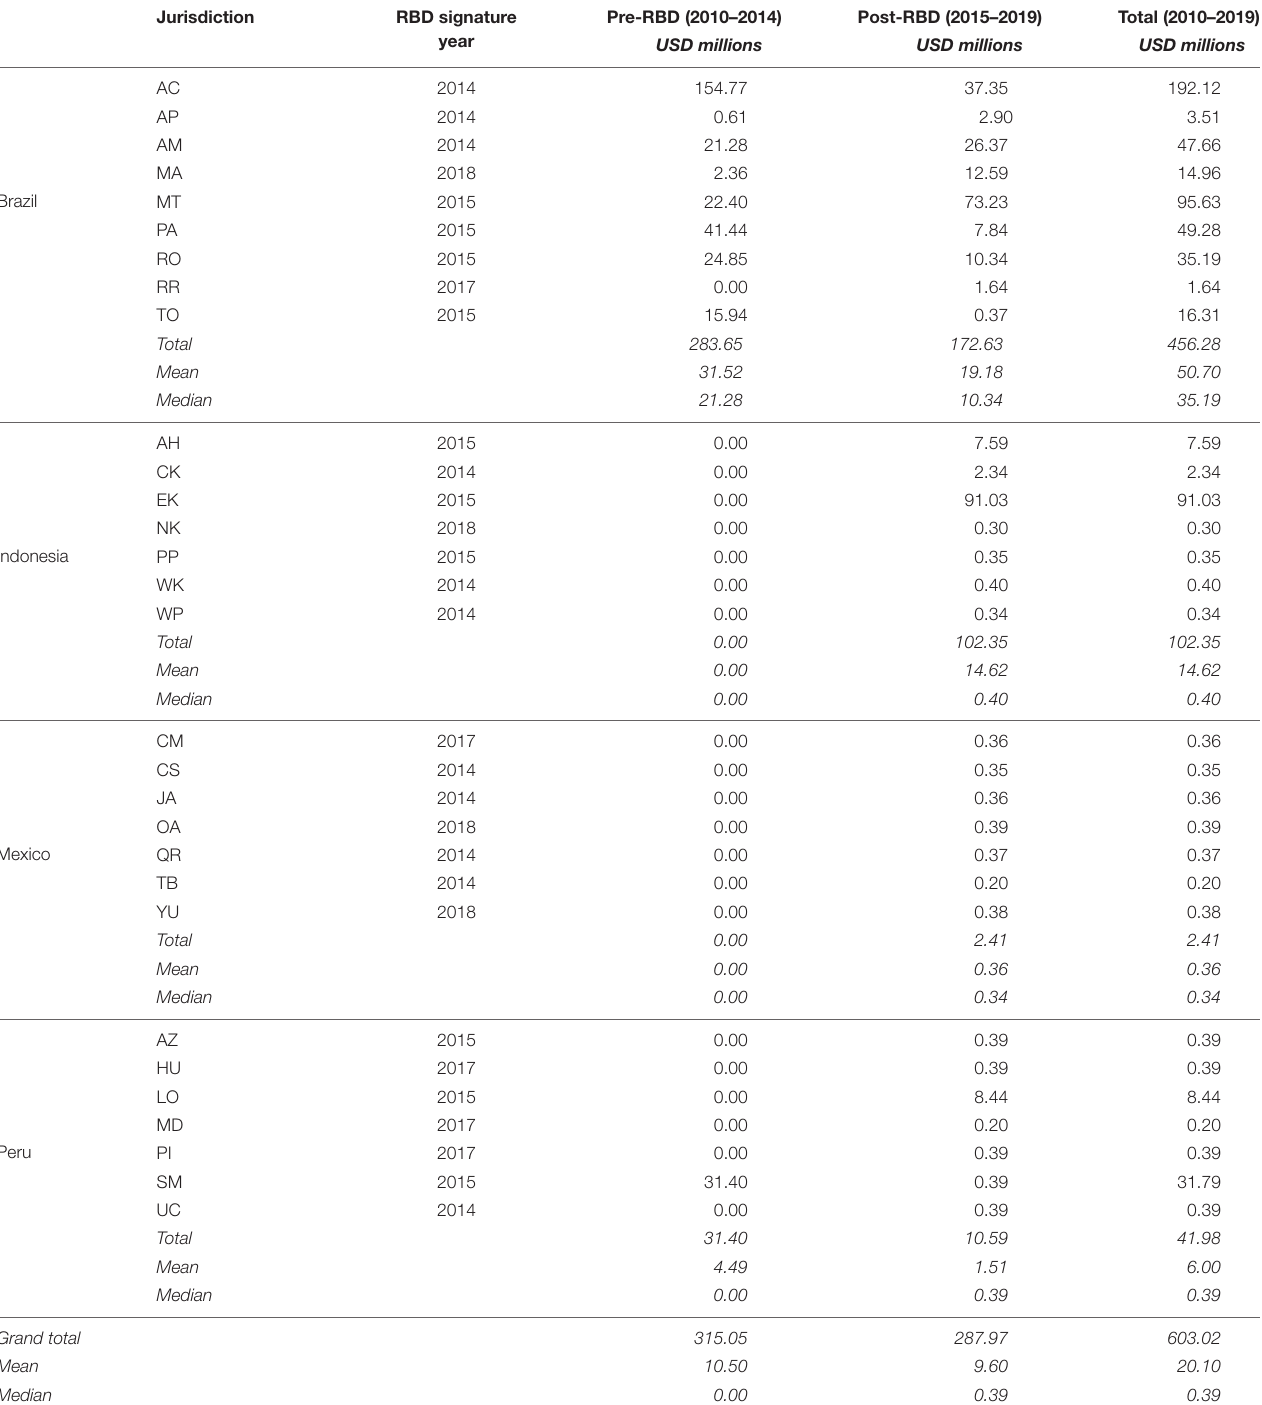
TABLE 7 | Total forest finance pledged to 30 RBD signatory jurisdictions from 2010 to 2019, segregated by the amounts pledged in the periods prior and subsequent to the RBD.